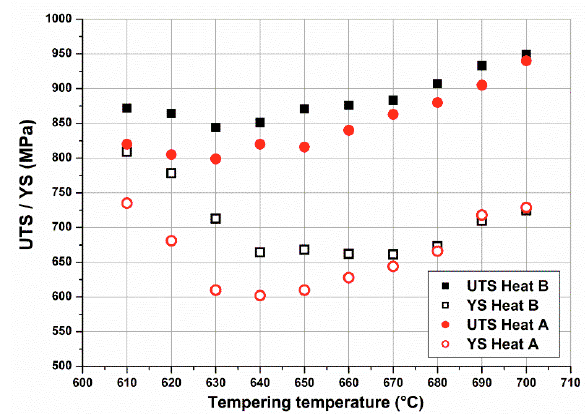
Figure 6. Yield (YS) and tensile (ultimate tensile strength, UTS) strengths of Heat A (red) and Heat B (black) after single tempering at different temperatures (610–700 °C).